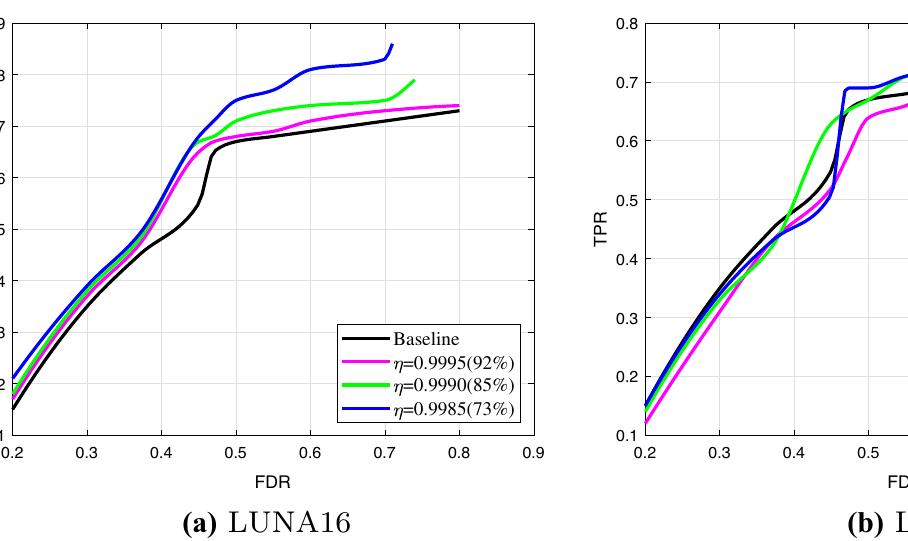
old. The uncertainty threshold used to generate a particular color’s curve is the same across plots in different dataset